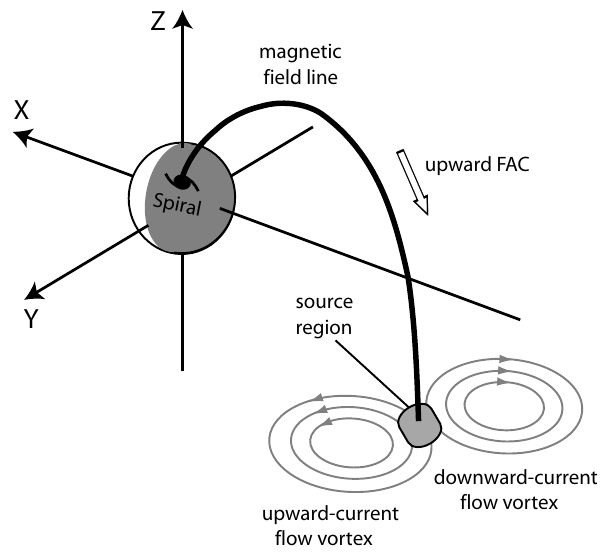
Fig. 11. Illustration of the connection of an auroral spiral and its source region in the magnetosphere, located between two oppositely rotating plasma vortices. The circular shape of the vortices is ideal- ized and is likely more stretched and irregular in reality. The source region maps into an ionospheric region of curl of EIC, indicating the existence of field-aligned currents, where the auroral spiral occurs.